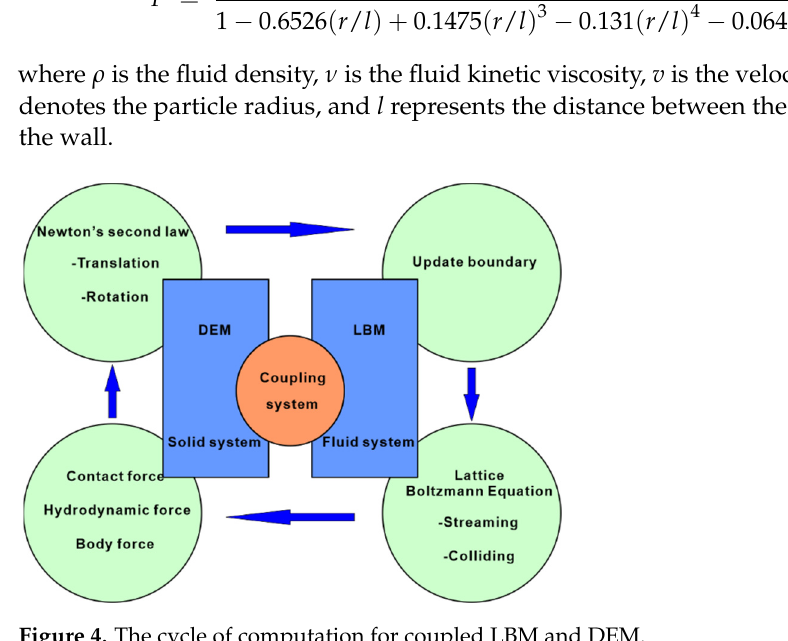
Figure 4. The cycle of computation for coupled LBM and DEM.